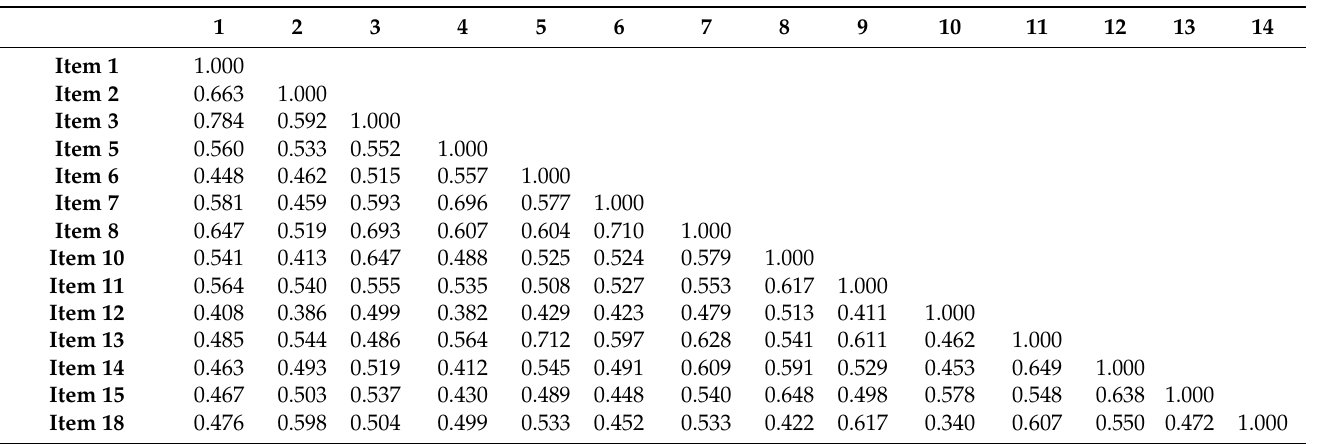
Table 2. Correlation